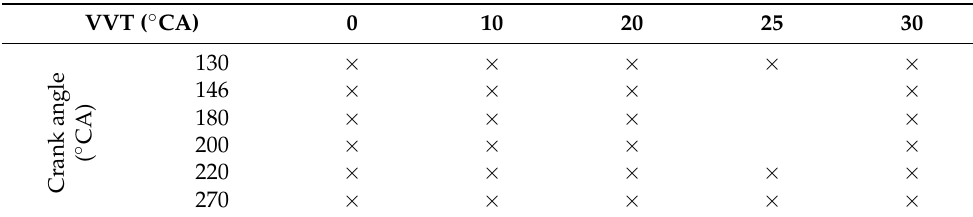
Table 1. PIV measurements.